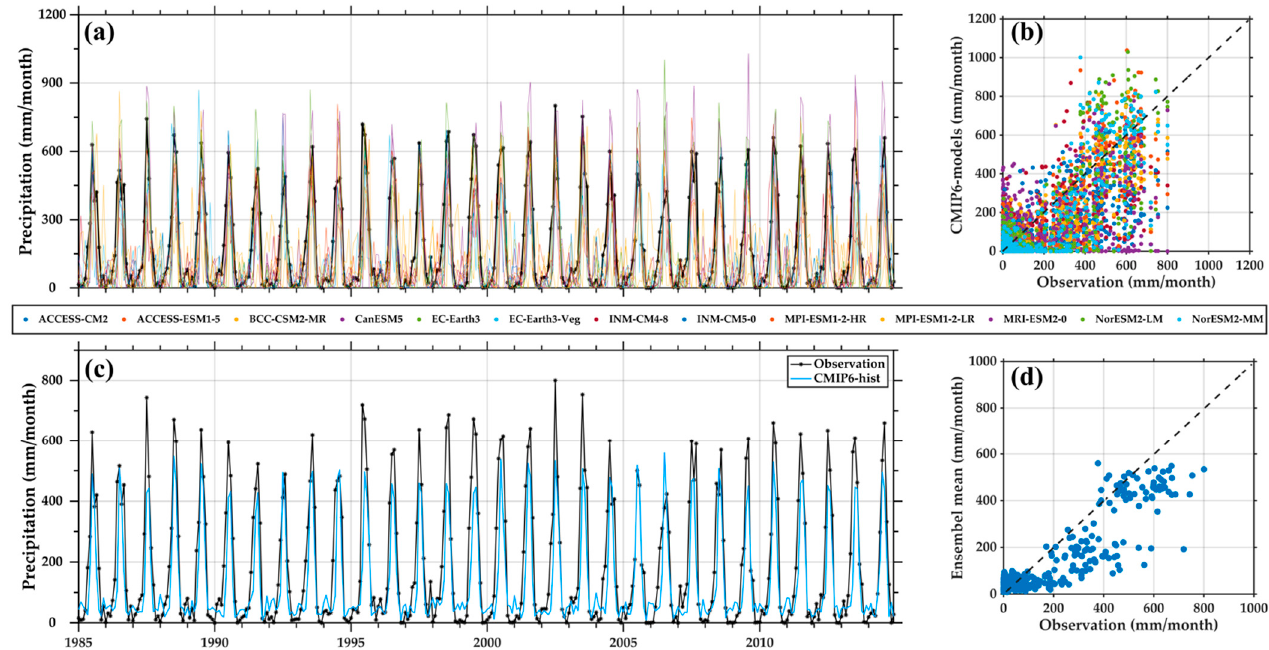
Figure A1. Performance comparison of monthly precipitation from ( a , b ) observation and 13 CMIP6 models and ( c , d ) observation and mean ensemble of 13 CMIP6 models. Black dash line in panel b and d represents the 1:1 line. Note: Ensemble members in panel a and b are represented by same color.